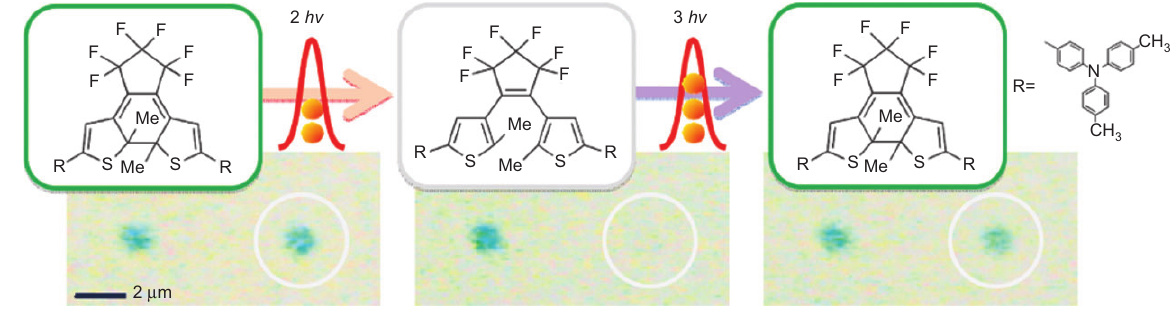
Figure 17 One-color reversible control of photochromic reactions in a diarylethene derivative [114] . Reprinted with permission from Ref. [114] . Copyright (2011) American Chemical Society.